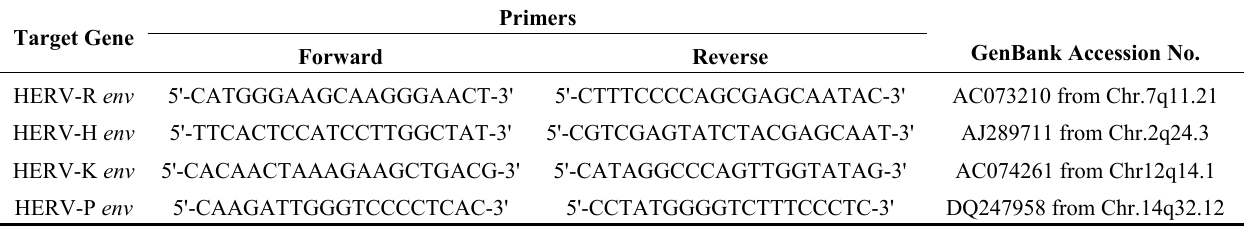
Table 2. Primers of HERVs env genes for realtime PCR